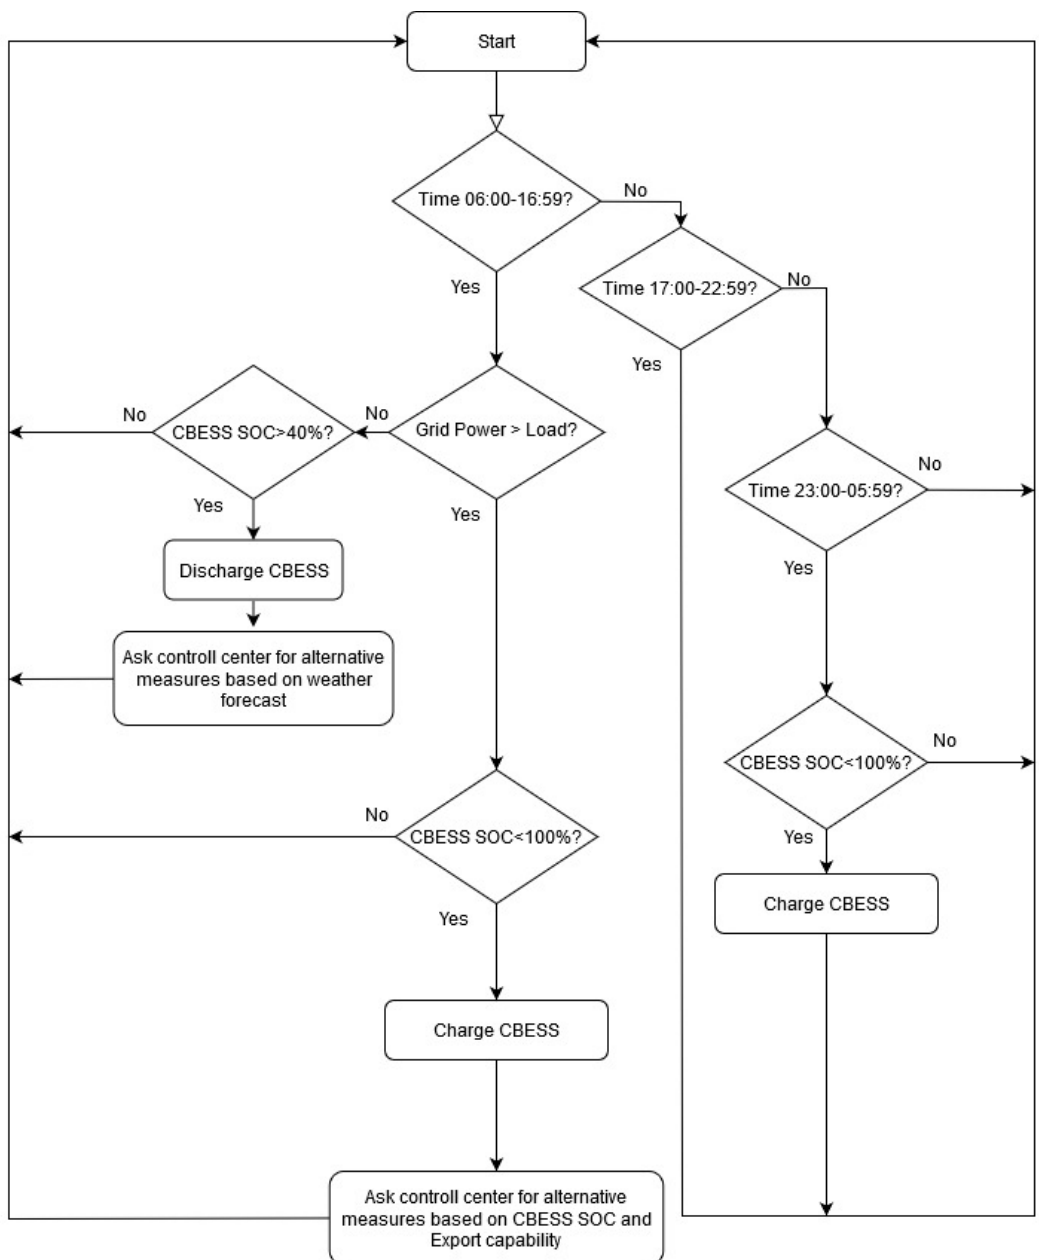
Figure A2. Flowchart of the CBESS control strategy.